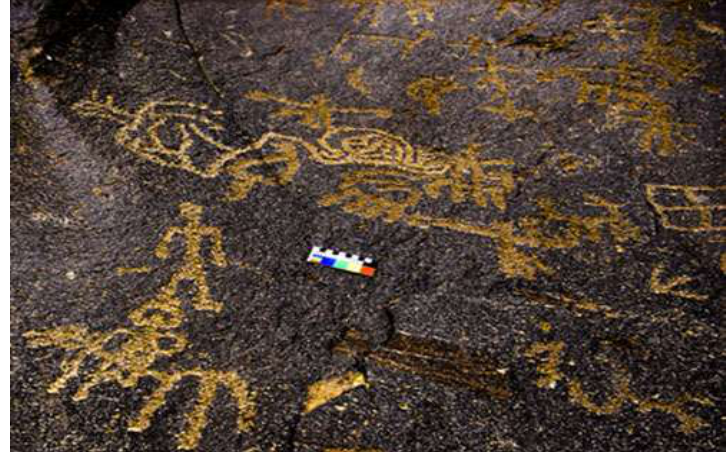
Figure 15. Qorwa, a big rock panel occurring on a steep surface and horizontal to the south, two periods are represented by anthropomorphs, zoomorphs and geometric